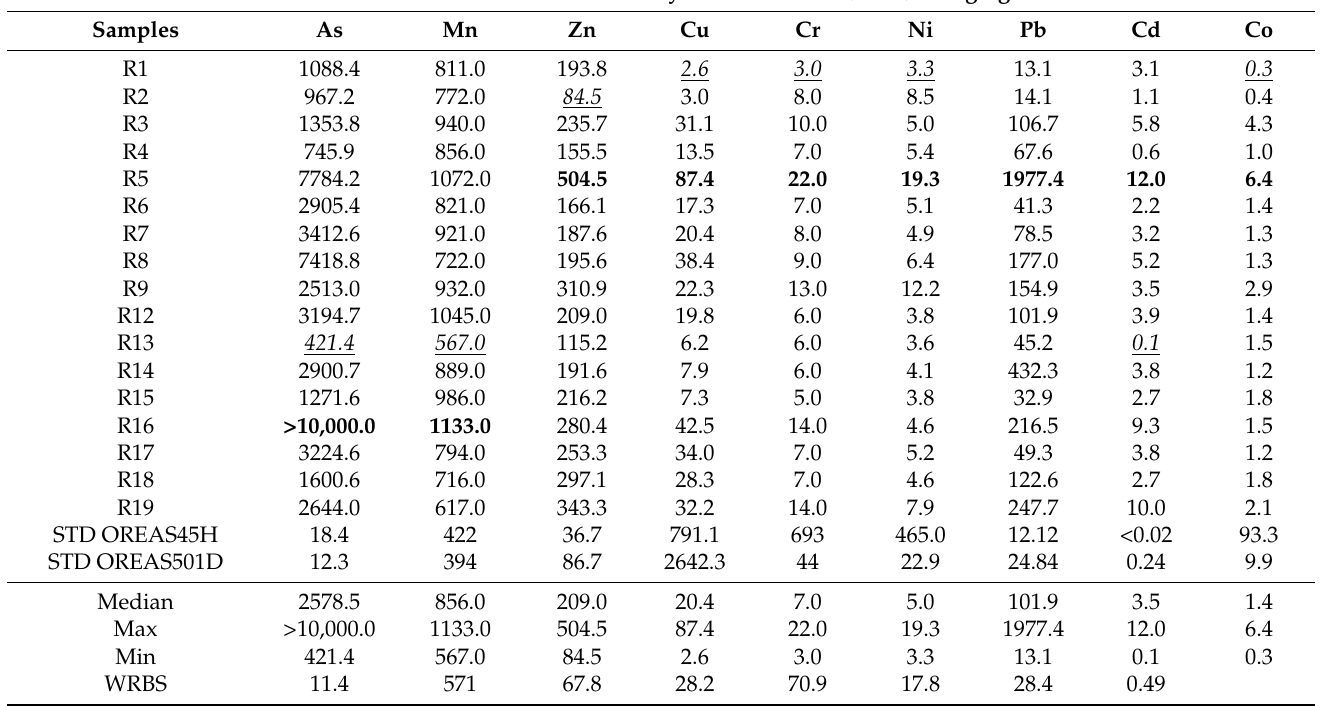
Table 1. Potentially toxic elemental concentration—PTE (mg/kg) measured in the soil surface samples collected at Regoufe’s mine main valley. For each element, the highest values are highlighted in bold and the lowest in italic underlined (WRBS—value for world reference background soils [25]). Potentially Toxic Elements (PTEs) in